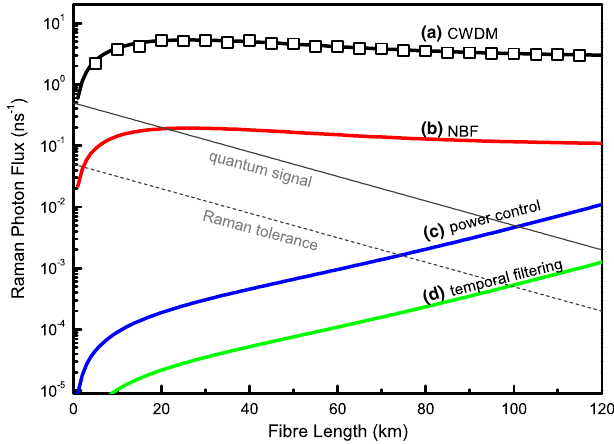
FIG. 3. Raman noise into the quantum receiver. (a) Measured (symbol) and calculated (solid line) Raman noise after Bob’s CWDM. (b) Raman noise after the narrow band pass filter (NBF). In both (a) and (b), two 0-dBm data lasers of 1591 and 1611 nm are launched simultaneously at Alice and Bob, respec- tively. (c) Reduced Raman noise after lowering the laser-launch powers. (d) Effective Raman noise received within the active time of the gated detectors. Solid lines (b)–(c) are calculated results.